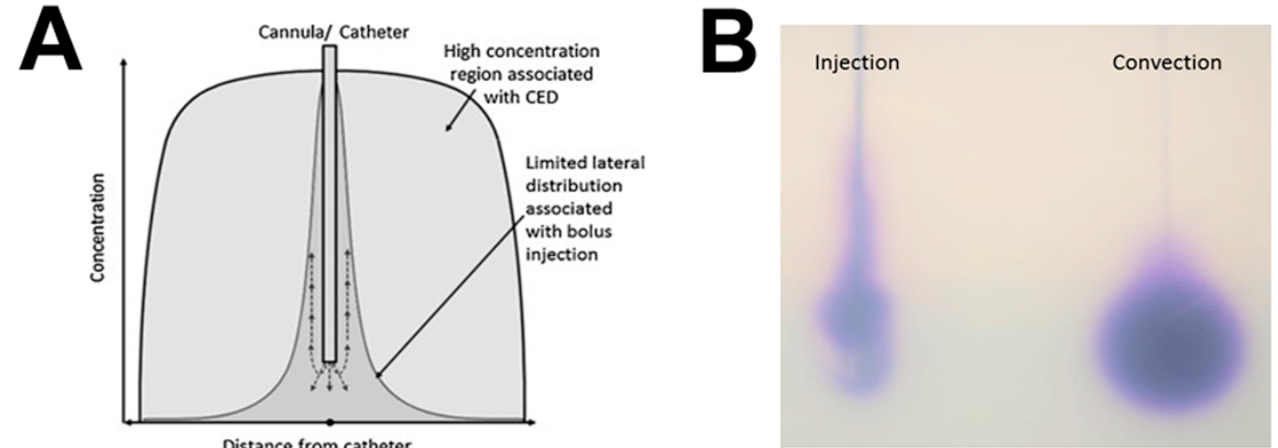
Figure 3. Diagrammatic illustration of the differences in drug distribution achieved by convection- enhanced delivery and intra-parenchymal injection. ( A ) Convection-enhanced delivery is a method of direct infusion of drug into the brain parenchyma under positive pressure with the aim of driving fluid through the extracellular space to cover large regions of parenchyma with a therapeutic drug concentration. In comparison, local injection, which does not create a positive pressure wave, causes local high concentration of the drug to regions of the brain only short distances from the infusion site. ( B ) Pictorial illustration of the difference between injection and convection using a blue dye infused into an agarose gel phantom. Black lines represent the position of the catheter. Injection causes local trauma and poor heterogeneous infusate distribution. Convection-enhanced delivery of the same volume of infusion causes homogenous distribution over a large volume of distribution (unpublished; doctoral thesis of co-author Will Singleton).